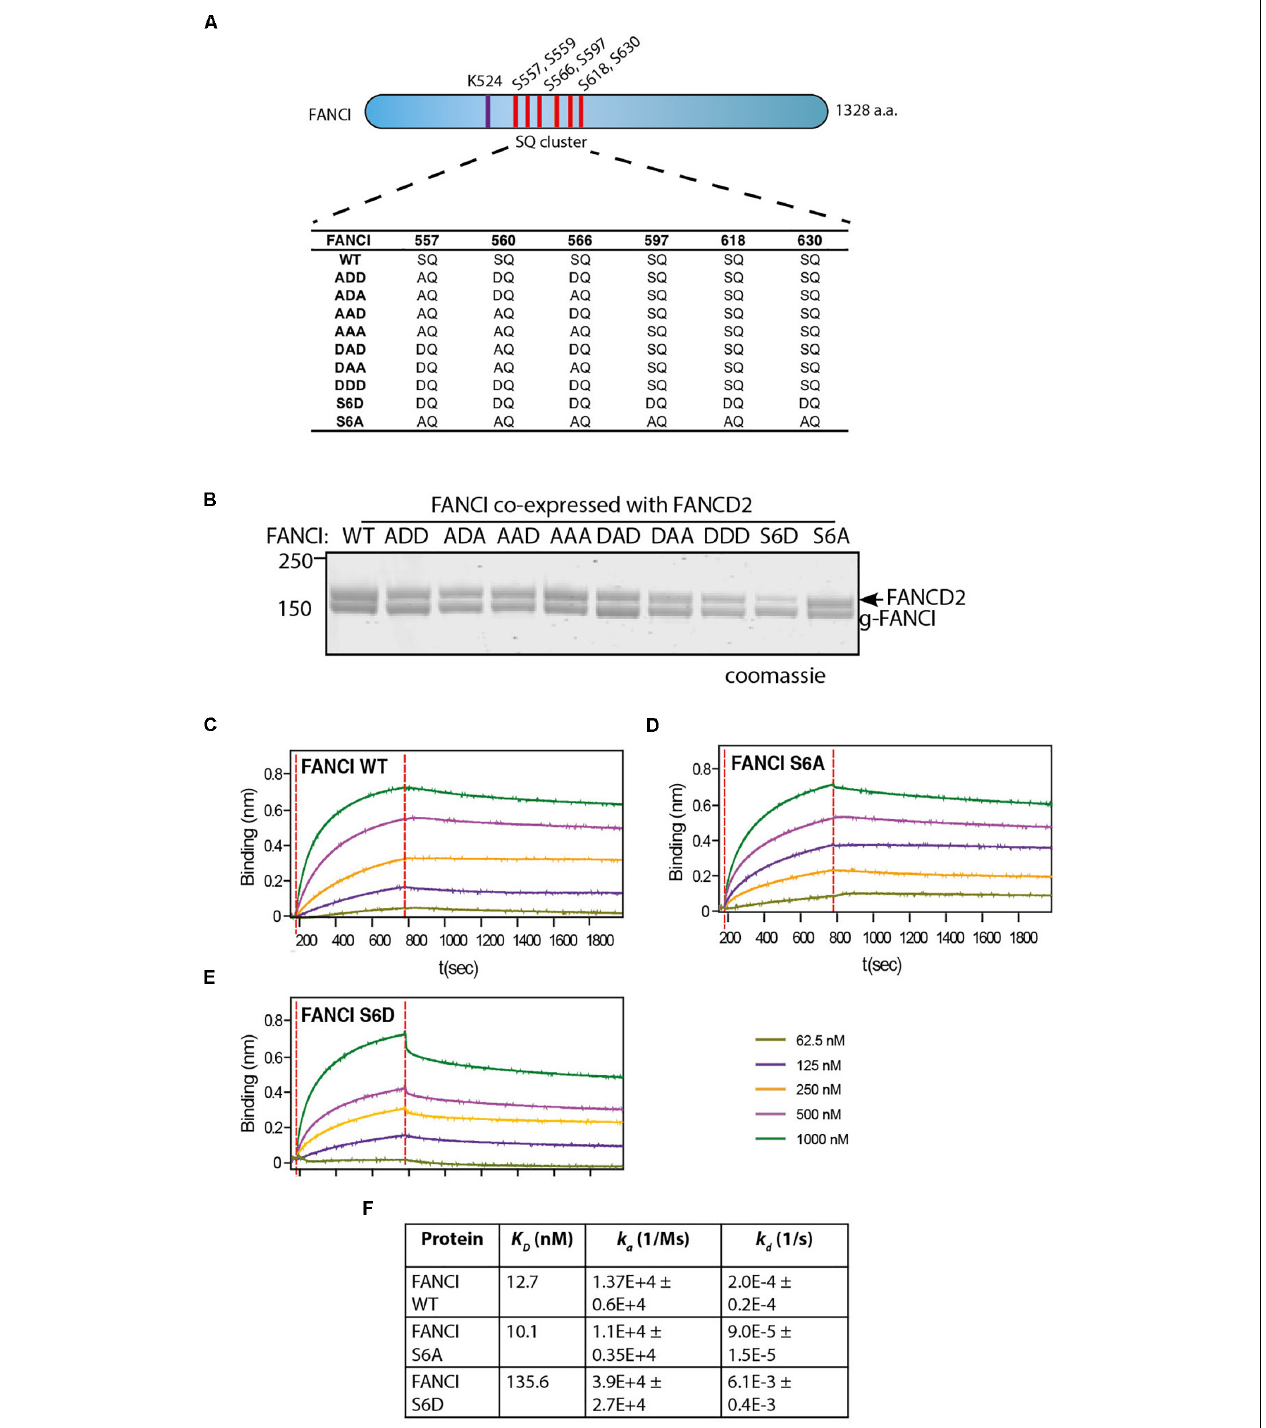
FIGURE 2 | FANCI phosphomimic mutant at six serine sites but not three serine sites dissociates ID2 complex. (A) Schematic of Xenopus FANCI, indicating the six phosphorylation sites within the SQ cluster region. The phosphorylation sites serine 557, 560, 566, 597, 618, and 630 were replaced either by aspartate (DQ) or alanine (AQ). The FANCI mono-ubiquitination site lysine 524 is also shown. (B) Coomassie stained SDS-PAGE of Flag-ID2 complex with StrepII-FANCD2 co-expressed with various flag-FANCI phosphomutants. (C–E) Biolayer inferometry (BLItz) sensorgrams obtained using StrepII-FANCD2-loaded biosensors in 20 ng/mL solution, with red dotted lines indicating the start of binding (left) and dissociation (right) phases. Biosensors loaded with StrepII-FANCD2 were incubated with different concentrations of FANCI wild type (WT), S6A or S6d mutants, as indicated to generate a series of sensorgrams. (F) Summary of dissociation constant (K D ), association (K a ), dissociation (K d ) rate constants obtained from the sensorgrams. Data are representative of four experiments.